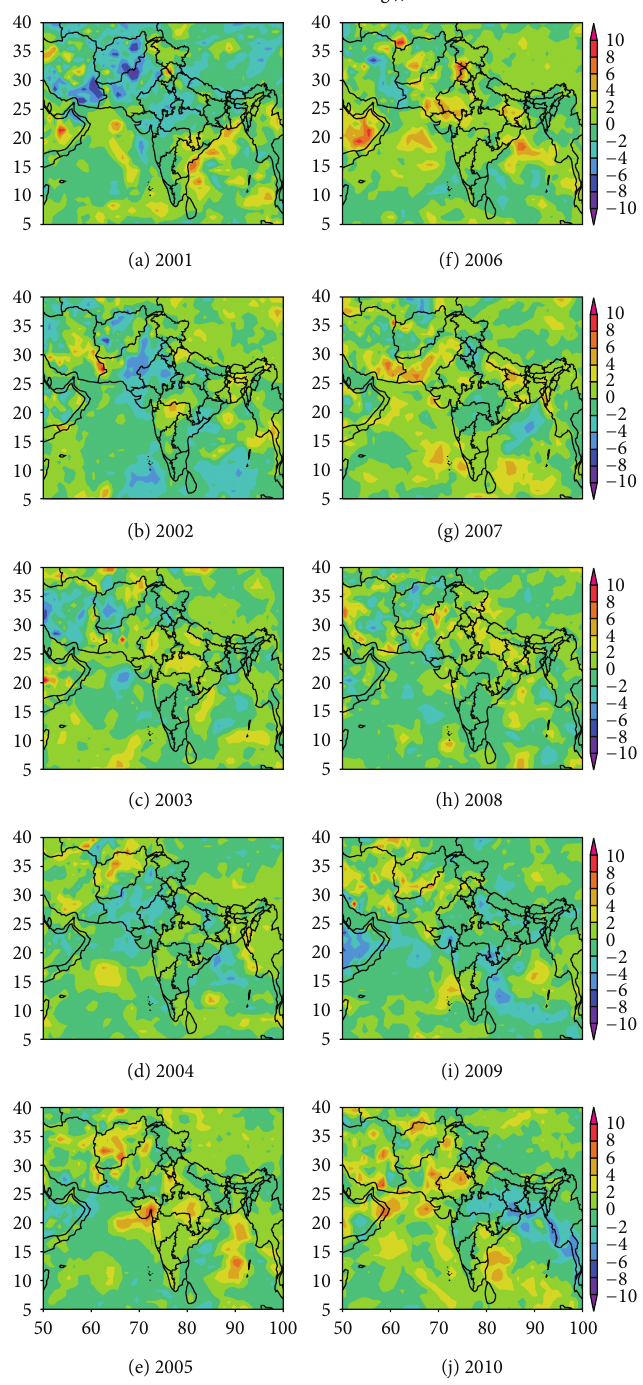
Figure 14: Anomalies in cloud optical thickness (COT) during the southwest monsoon season (JJAS) in (a) 2001, (b) 2002, (c) 2003, (d) 2004, (e) 2005, (f) 2006, (g) 2007, (h) 2008, (i) 2009, and (j) 2010 over the Arabian Sea, India, and the Bay of